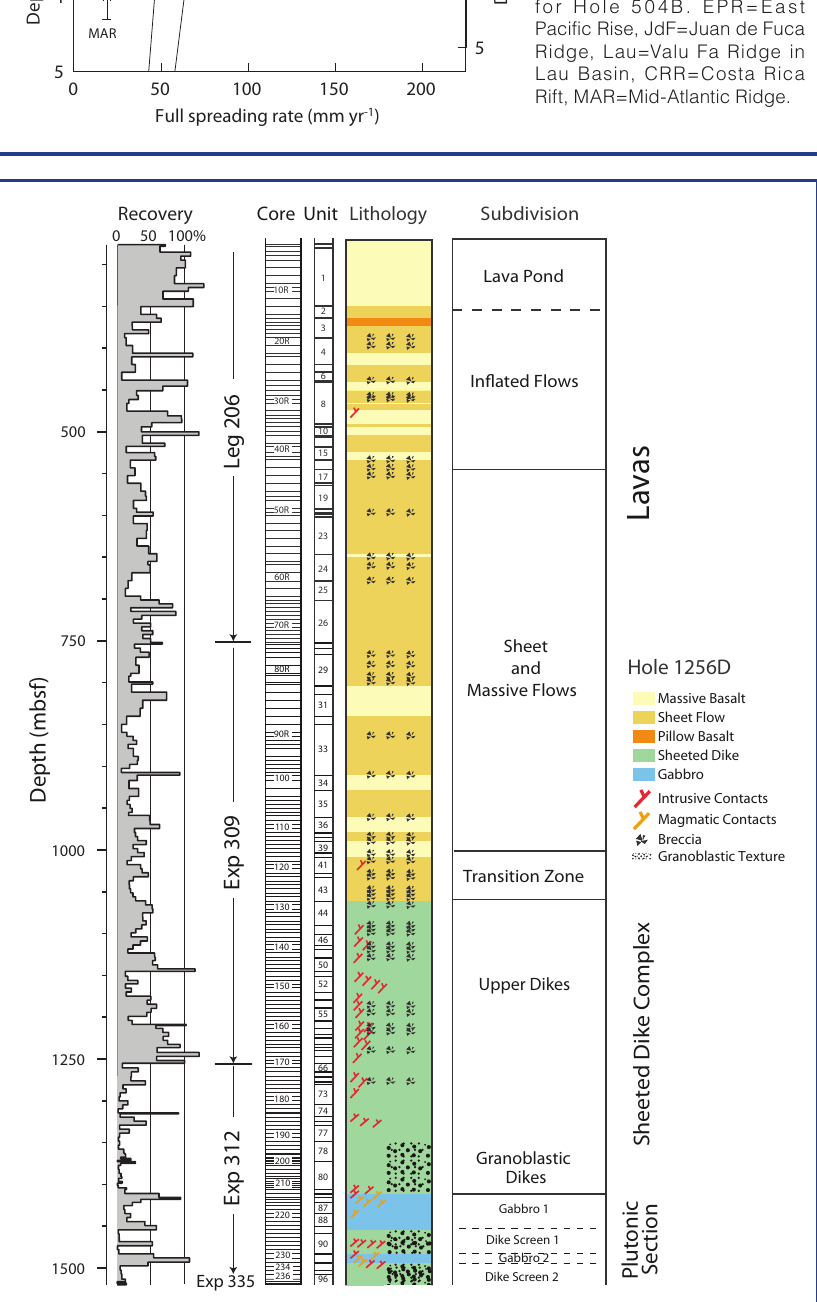
Figure 3. Depth to axial low-velocity zone plotted against spreading rate (Purdy et al., 1992; Carbotte et al., 1997). Depth versus spreading rate predictions from two models of Phipps Morgan and Chen (1993) are shown, extrapolated subjectively to 200 mm y -1 . Penetration to date in Holes 504B and 1256D is shown, with the depth at which gabbros were intersected indicated by the red box. Following core descriptions, a thickness of ~300 m of off-axis lava is shown for Hole 1256D and assumed for Hole 504B. EPR=East Pacific Rise, JdF=Juan de Fuca Ridge, Lau=Valu Fa Ridge in Lau Basin, CRR=Costa Rica Rift, MAR=Mid-Atlantic Ridge.